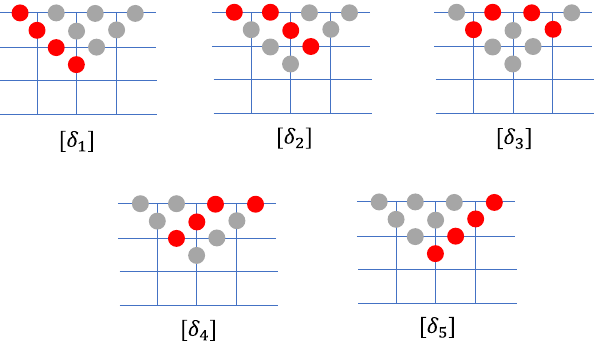
FIG. 8. Restrictions of the diagonal δ i onto O define a basis set of codewords for the top-level code.